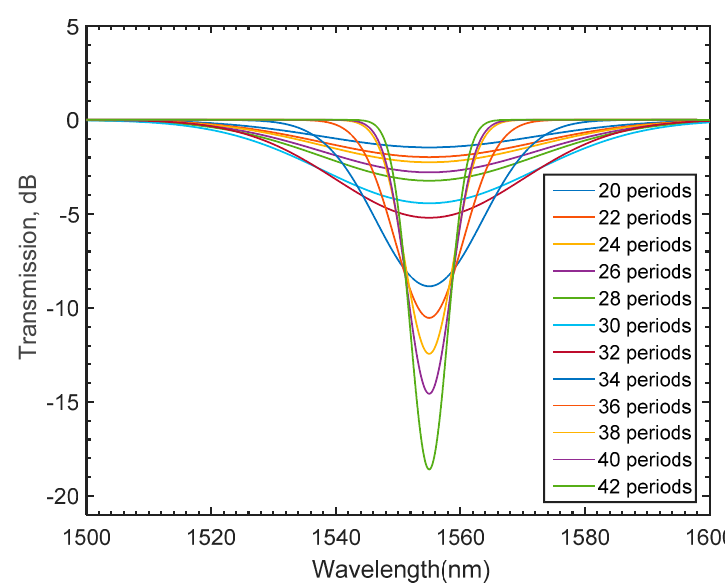
Figure 8. Gradual growth of LPFG in the modeled single mode fiber for different number of periods using mapped mesh.